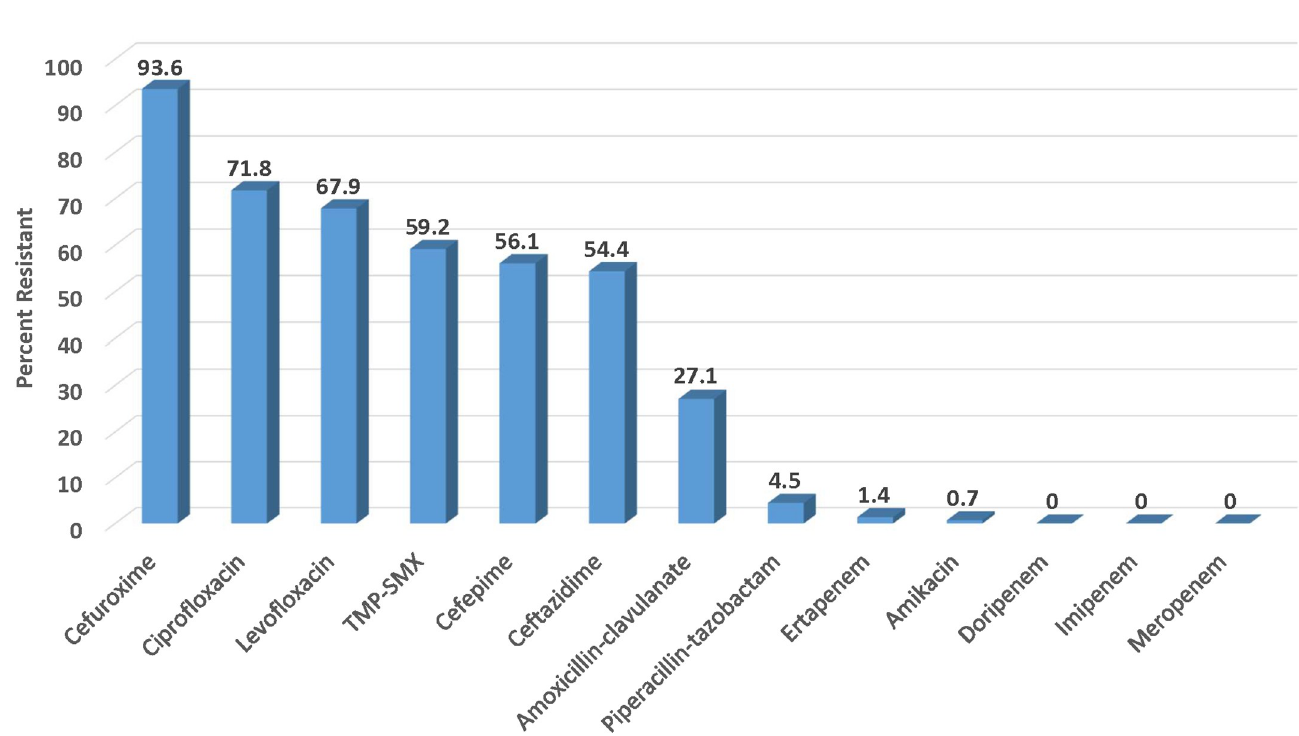
Fig 2. Antibiotic resistance among 287 ESBL phenotypes of UTI isolates of E . coli collected in the USA in 2017.